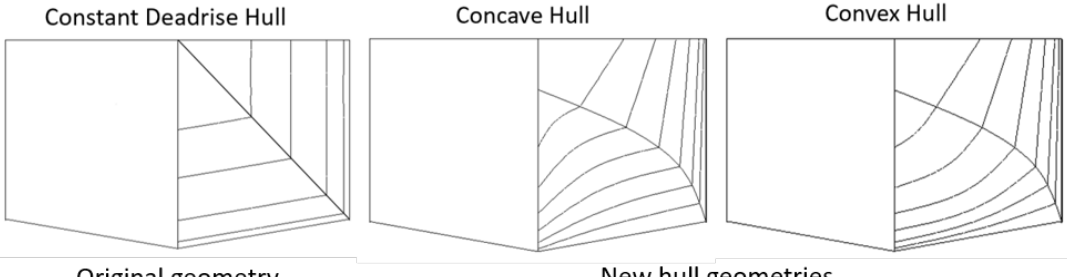
Figure 3. Transverse hull lines of three studied configurations.